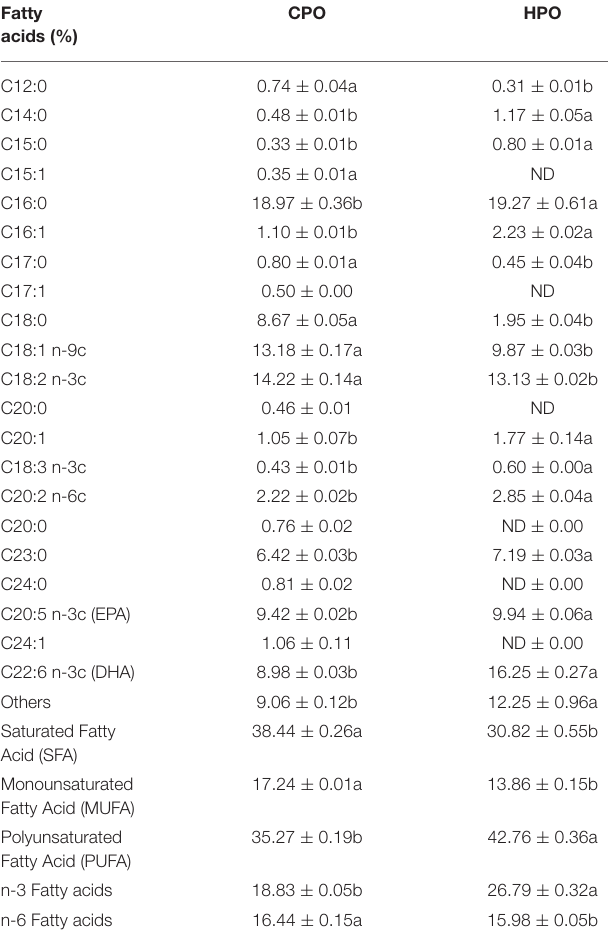
TABLE 1 | Fatty acid profiles of shrimp oil extracted from cephalothorax and hepatopancreas. Fatty acids (%)